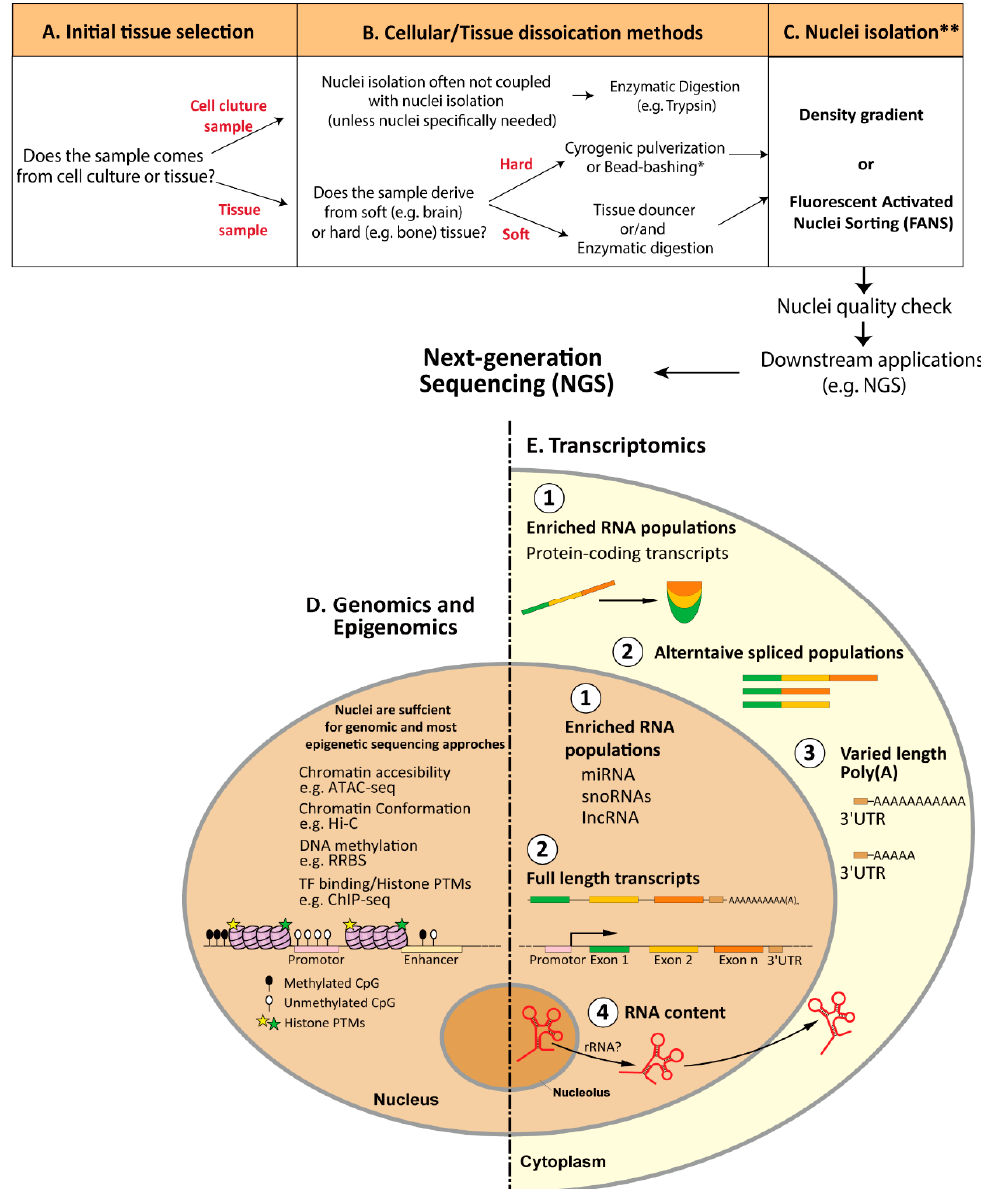
Figure 4. Overview of the application of nuclei-based studies with next-generation sequencing approaches. ( A – C ) . Guideline for selecting the optimal nuclei-isolation pipeline coupled with NGS. ( A ). Selection of sample material in vitro or in vivo. ( B ). Tissue/Cellular dissociation methods. According to the sample type, samples can be dissociated with mechanical dissociation (e.g., tissue samples) or enzymatic digestions (e.g., cell culture). Soft tissues (e.g., brain) can be homogenized with a tissue Douncer (in combination with enzymatic digestion if required) whereas hard tissues require stronger dissociation methods such as cryogenic pulverization or bead-bashing. * Dissociation of hard tissue types might require further optimization steps. ( C ). Nuclei-isolation methods. Density gradient and FANS are the most frequent methods to isolate nuclei. ** The selection of nuclei- isolation method depends on cell type, input material and downstream application. ( D ). Genomics and Epigenomics. The use of nuclei is sufficient for most epigenetic sequencing approaches as the content of interest (e.g., gDNA, histones and chromatin-associated modifications) is located within the nucleus. ( E ). Transcriptomics. Differences between nuclear and cytoplasmic transcripts